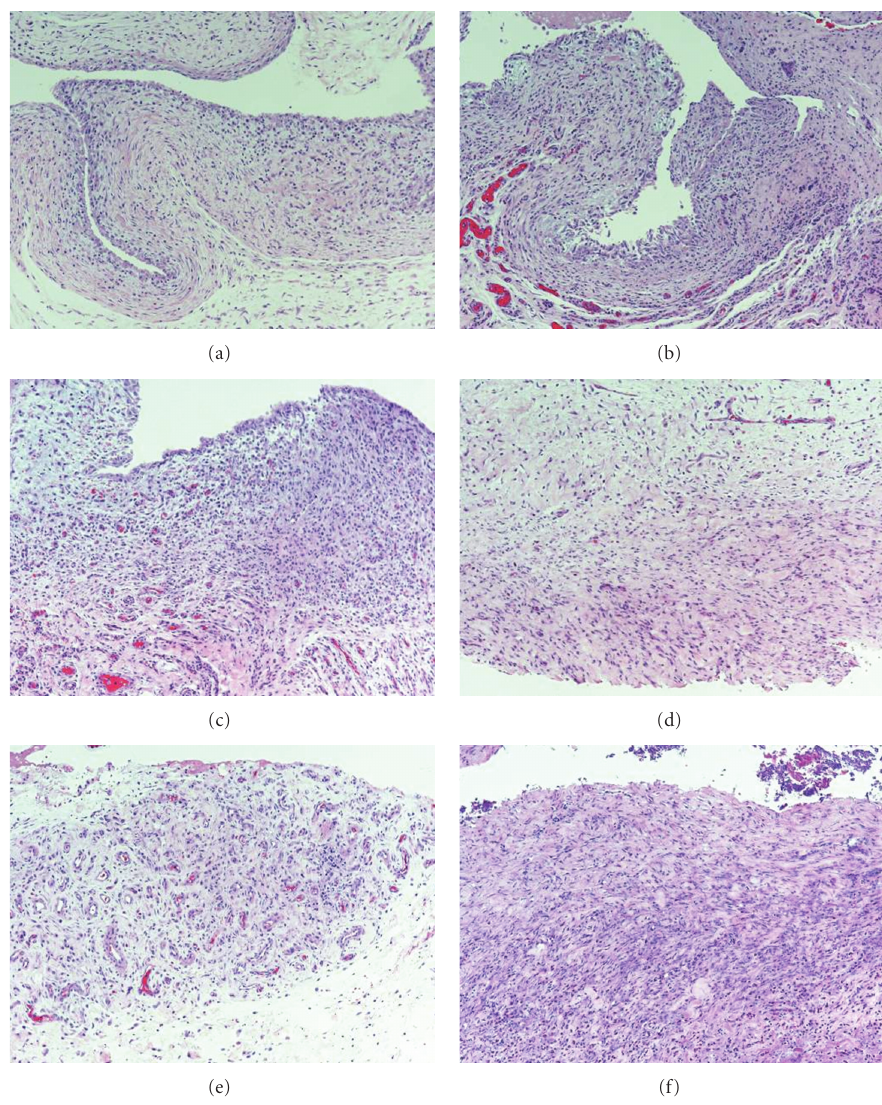
Figure 4: Representative digital micrographs (100x magnification) taken during the histological review of tissue segments from animal 10. (a) Test catheter 3, segment 5: neutrophils and/or macrophages are present, with inflammation in the lumen, (b) test catheter 3, segment 7: neutrophils and/or macrophages are present, with inflammation in the lumen. There is an inner layer which would have been adjacent to the catheter which is composed of well-vascularised immature connective tissue with a mild inflammatory reaction. There is also an outer layer of mature, well-organized, and uninflamed fibrous connective tissue. (c) Test catheter 3, segment 5: neutrophils and/or macrophages are present; inflammation extends to include the subcutis outside the connective tissue tunnel. (d) Control catheter 3, segment 5: neutrophils and/or macrophages are present, with inflammation in the lumen. (e) Control catheter 3, segment 7: neutrophils and/or macrophages are present; inflammation extends to include the subcutis outside the connective tissue tunnel. (f) Control catheter 3, segment 9: neutrophils, macrophages and lymphocytes are present; inflammation extends to include the subcutis outside the connective tissue tunnel. There is a thick necrotic mass of debris in lumen, with more general inflammation of